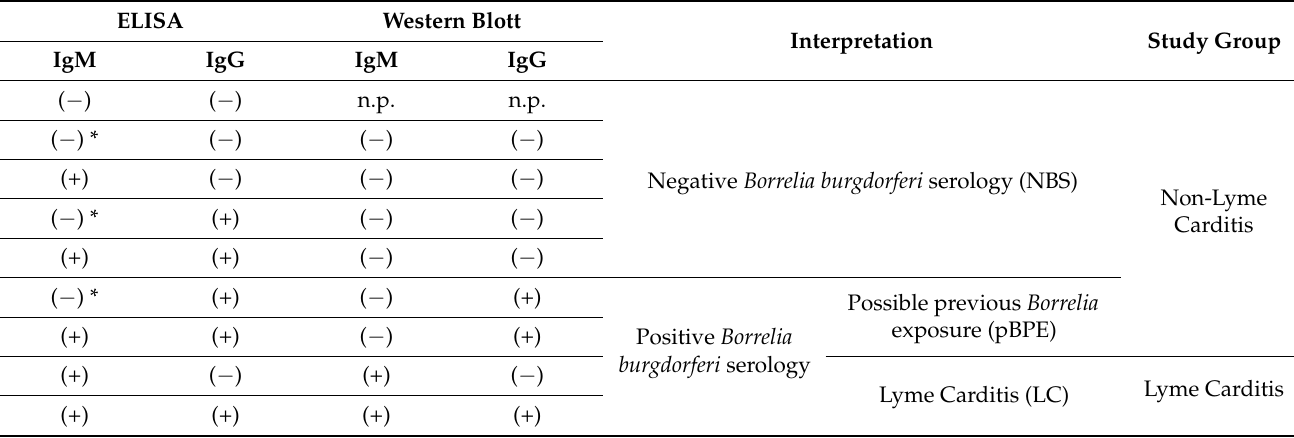
Table 1. Patients’ assignment to groups according to serology